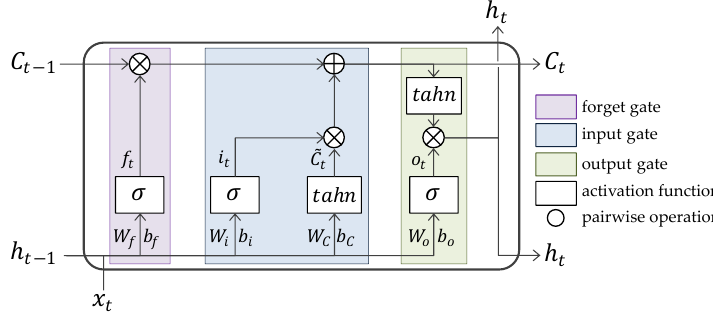
Figure 6. The structure of an long short-term memory (LSTM) cell.